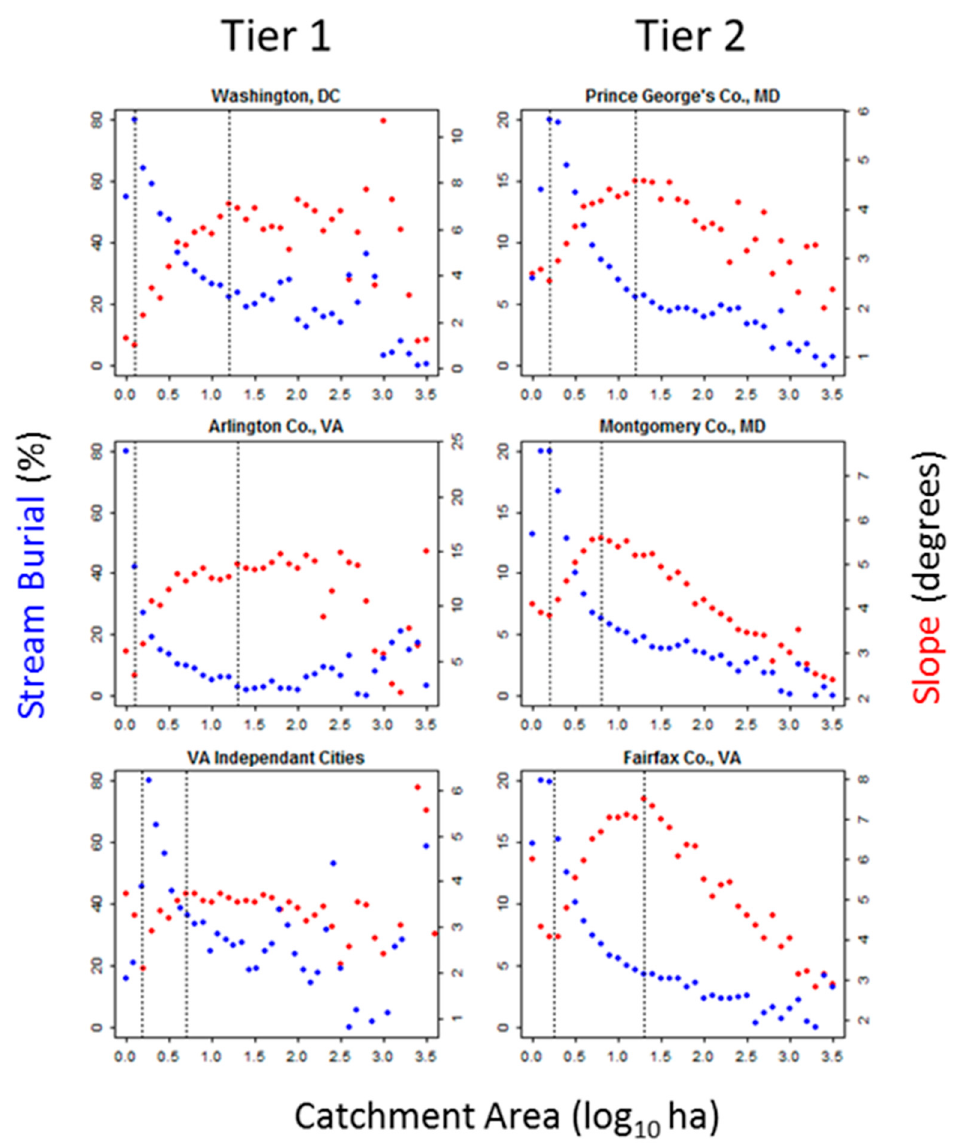
Figure 9. Stream burial (%) and slope (degrees) in relation to catchment area (log 10 ha) for Tier 1 and Tier 2 counties. Dashed vertical lines represent local burial maxima ( left ) and minima ( right ) in % stream burial. Data for the independent cities of Virginia were analyzed as a single entity, and the results plotted together.